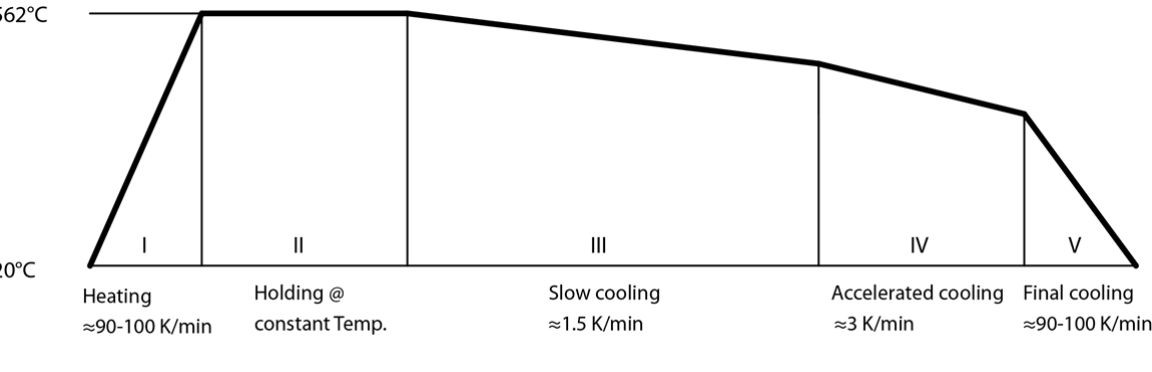
Fig. 8 annealing cycle for borosilicate